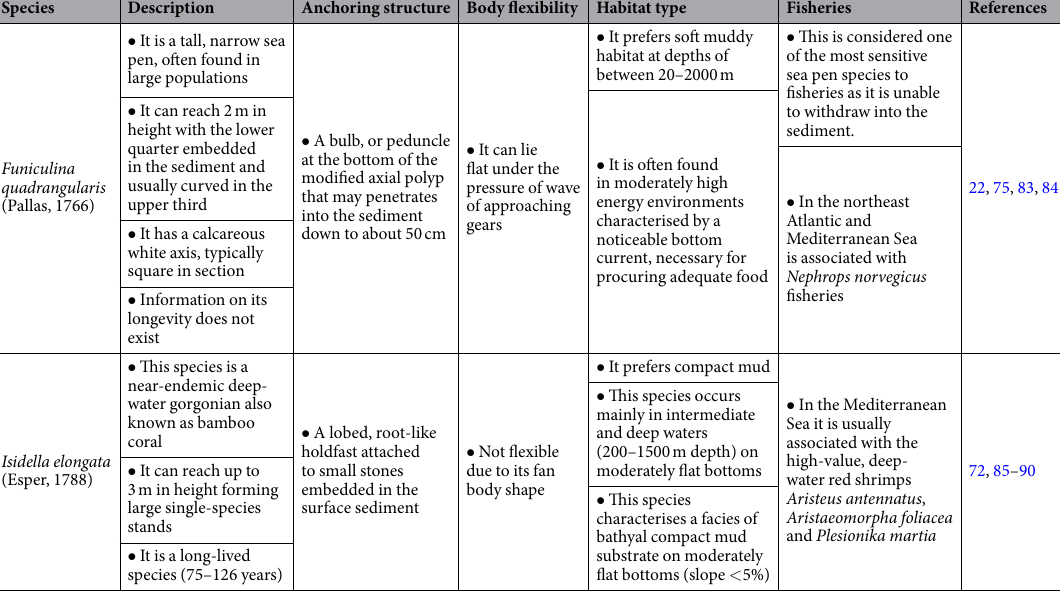
Table 1. Information relative to the biology and fisheries of Funiculina quadrangularis and Isidella elongata